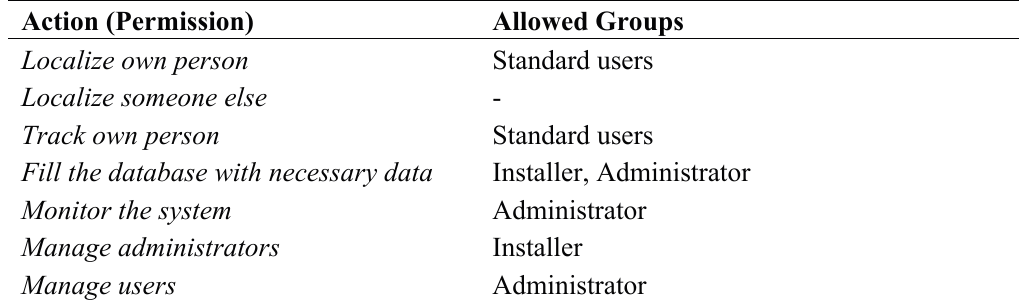
Table 3. Actions in the localization system and user groups allowed performing